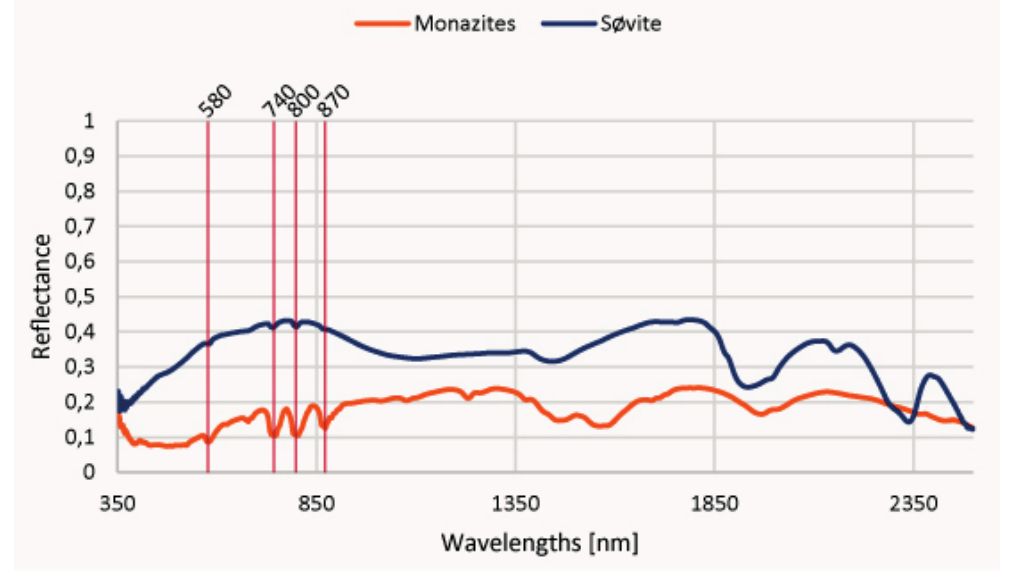
Figure 1. Two reference spectra for monazite (a neodymium-bearing mineral) and a monazite-rich rock sample (a calcitic carbonatite from the Fen complex). The key spectral characteristic